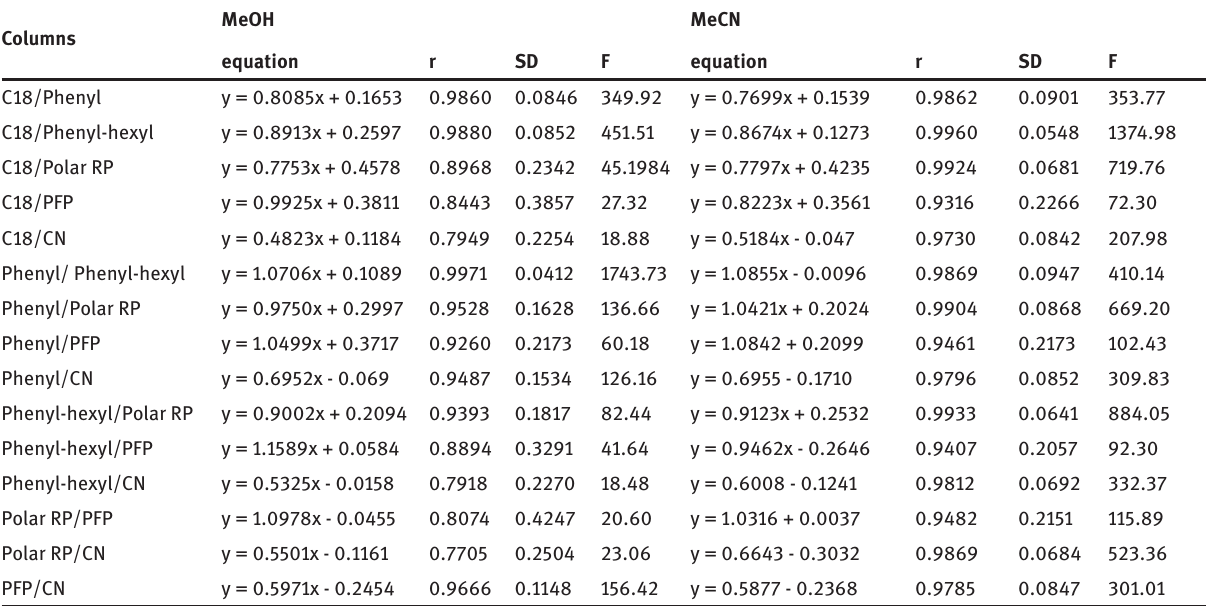
Table 3: Correlation of plots of log k for one column vs. another and for mobile phases containing MeOH or MeCN as organic modifiers, 20% acetate buffer at pH 3.5 and 0.025 ML -1 DEA